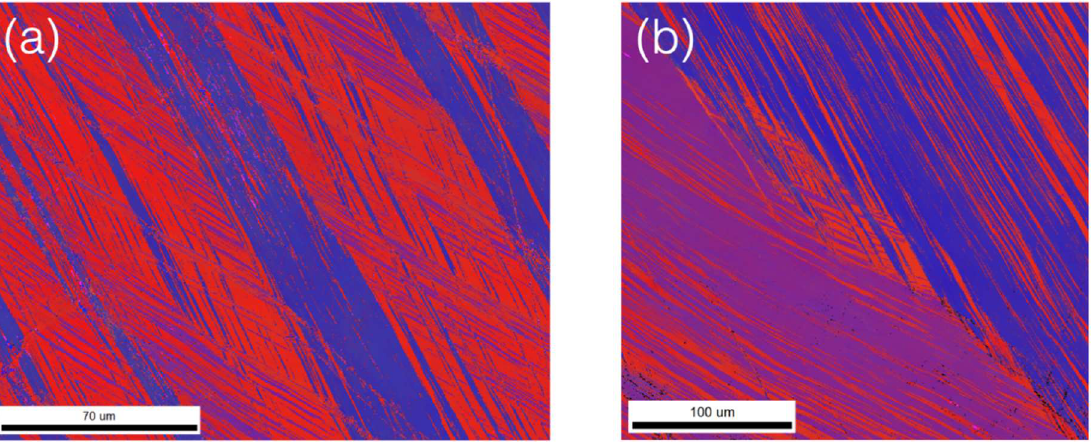
Figure 3. EBSD maps of magnified regions 2 ( a ) and 3 ( b ) from Figure 2 displayed in the Euler